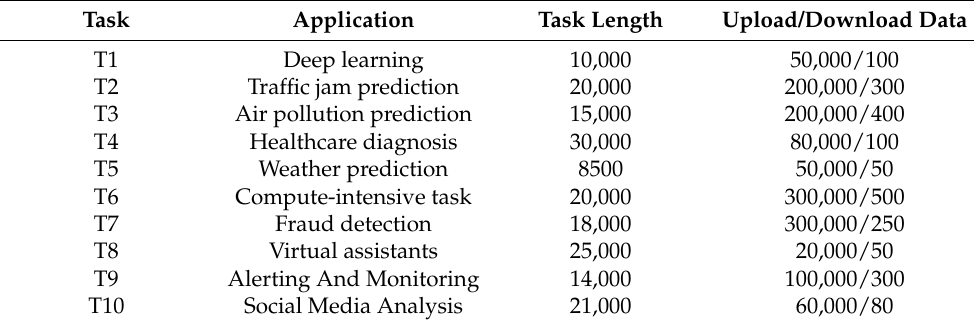
Table 6. Application types used in the simulation.